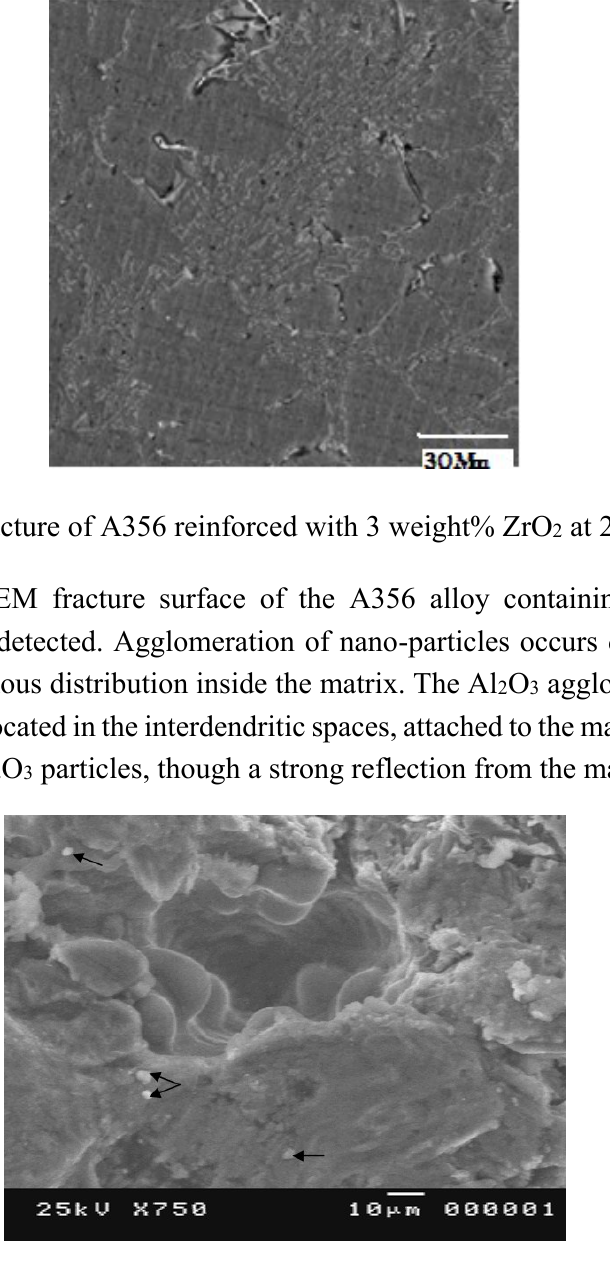
Figure 13. SEM for A356 Alloy containing Al 2 O 3 agglomerated